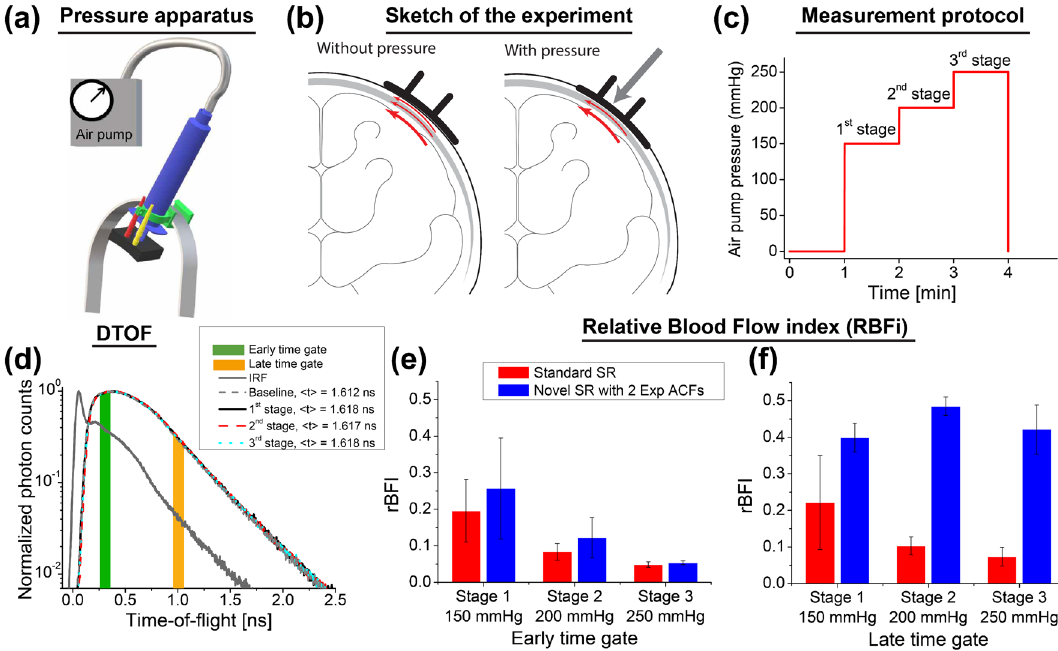
Figure 5. Measuring the relative blood flow index in the human forehead under variable pressure in vivo. ( a ) The sketch of the pressure apparatus ( a ), experiment ( b ), and tissue pressure protocol ( c ). ( d ) IRF and representative DTOFs for various stages of the experiment. Relative blood flow for early ( e ) and late time gate ( f ) are compared between the standard (red bars) and novel (blue bars)